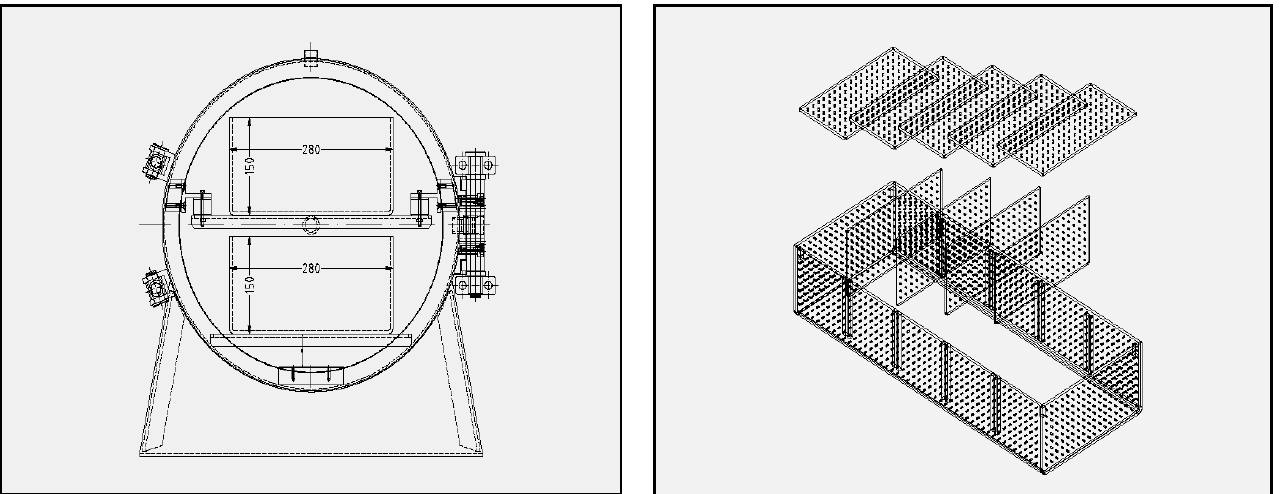
FIGURE 1 - Blueprint of the first phase - frontal view of the project with the specifications techniques of the Hyperbaric Chamber (right). Schematic drawing of the acrylic drawers